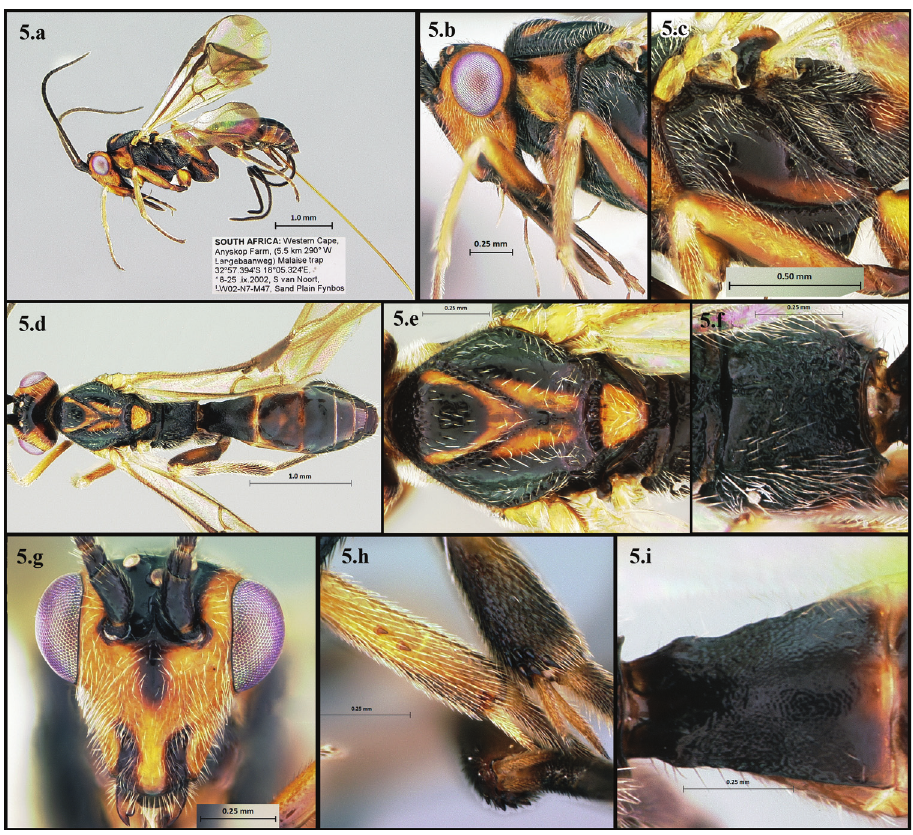
Figure 5. Camptothlipsis aagota a lateral habitus b lateral head c mesopleuron d dorsal habitus e dorsal thorax f propodeum g anterior head h mid and hind tibial spines i first median tergite of Color - Head - Orange-yellow except black as follows: vertex, spot on dorsomedial face, clypeal pit area, labrum, and mouthparts. Antenna and mandible brown. Meso- soma - Black except orange-yellow as follows: pronotum, edges of notauli, two thick medial longitudinal bands on mesoscutum, posteromedial scutellum, longitudinal band above sternaulus, dorsomedial spot on metapleuron. Metasoma - Terga mostly black with some orange-yellow highlights, ovipositor yellow, ovipositor sheath black. Wings - Translucent to pale yellow-brown, veins brown to light brown. Legs - Yellow, except brown as follows: trochanter, basal patch on hind femur, apical tibia and tarsal segments. Hind coxa mostly black.